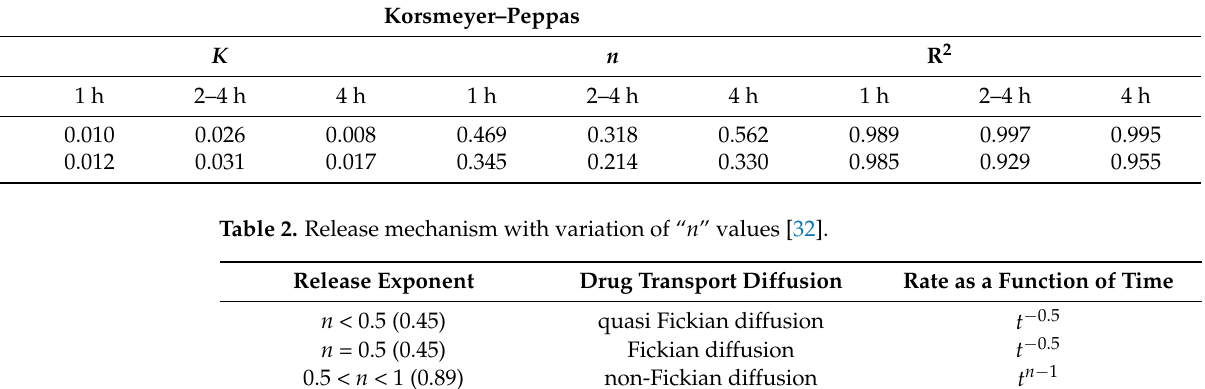
Table 1. The release’s kinetic parameters by applying the Korsmeyer–Peppas model. Korsmeyer–Peppas